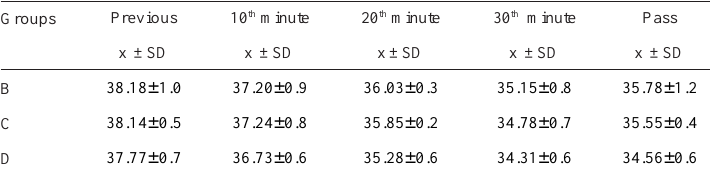
Table 5. Rectal temperatures (°C) Groups